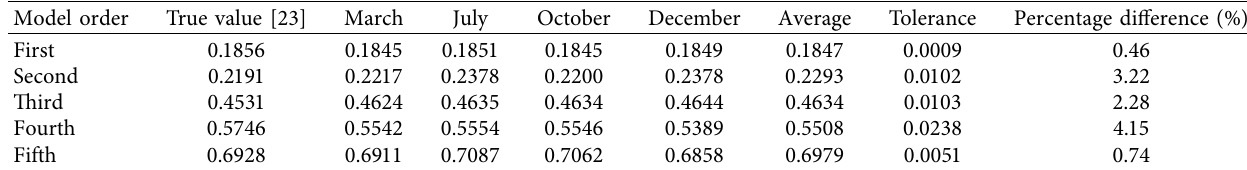
Figure 18: Stability diagram of hierarchical clustering (July). Table 3: Comparison between improved EEMD results and real values